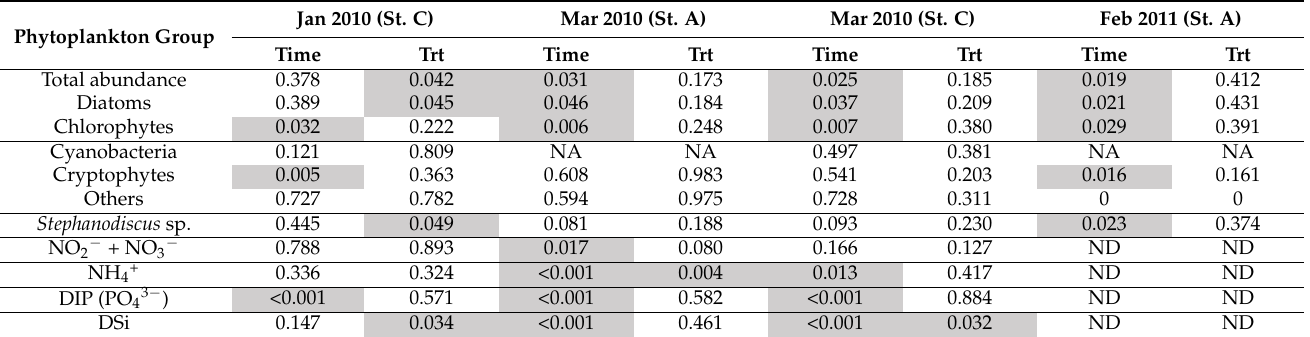
Table 4. Results of the RM-ANOVA analyses on HA addition treatments for total, net-, and nanosized phytoplankton at a significance level of 0.05. Time and Trt represent the differences over time and between the treatments (control vs. HA (5 ppm) addition), respectively, and T*Trt represents differences between the treatment and over time. Significant p -values (<0.05) are highlighted in gray. Chloro, Chlorophytes; Cyano, Cyanobacteria; Crypto, Cryptophytes; Others, Other groups; NA, No appearance; ND, No